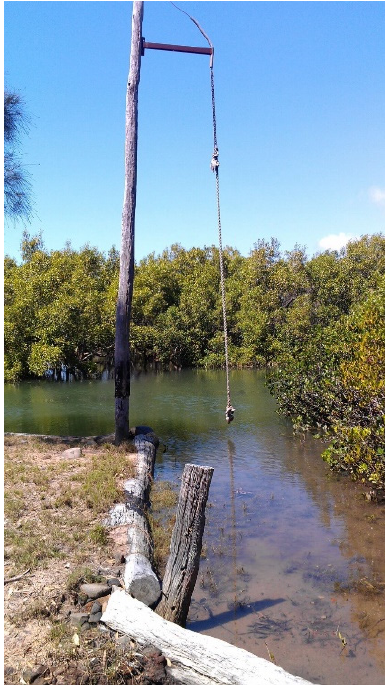
Figure 6. Maintaining a positive outlook: Kangaroos show how seeing wild animals make partici- pants feel happy and positive.